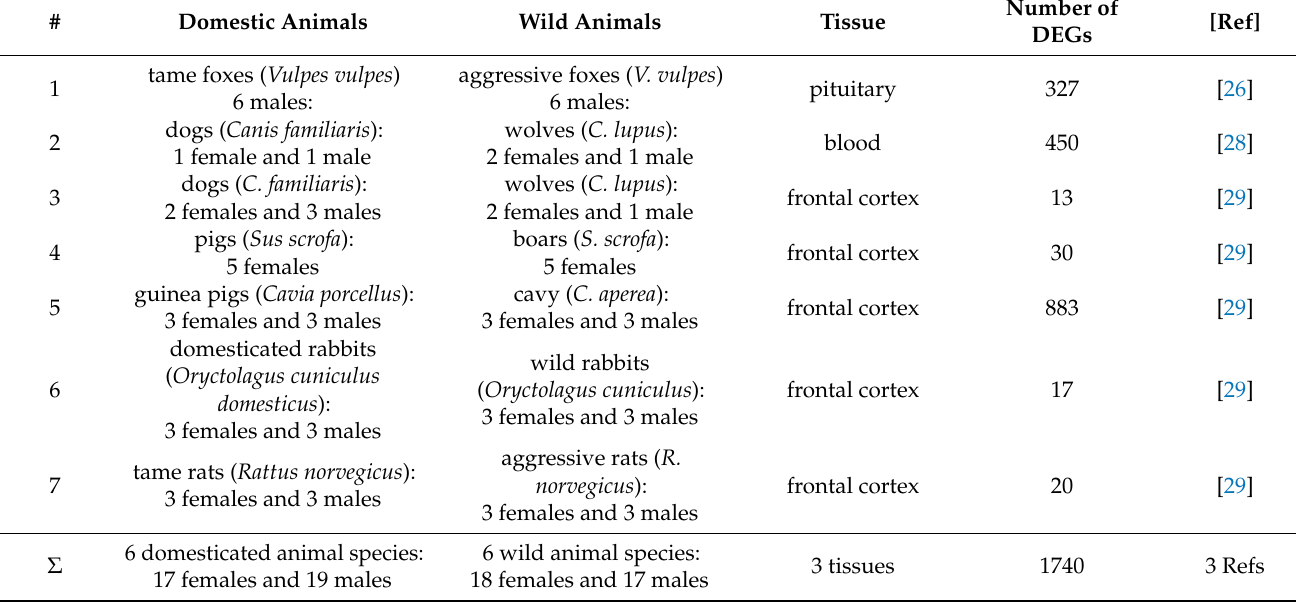
Table 1. The investigated genome-wide RNA-Seq transcriptomes of domestic animals with their wild congeners, publicly available in database